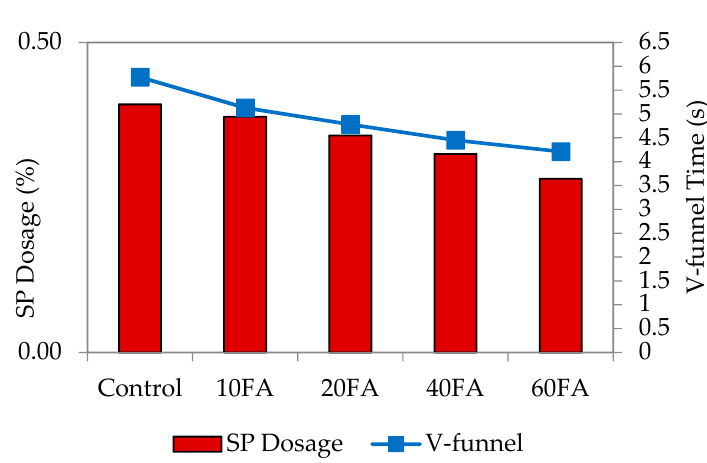
Figure 7. V-funnel time and SP dosage at w/b 0.45.